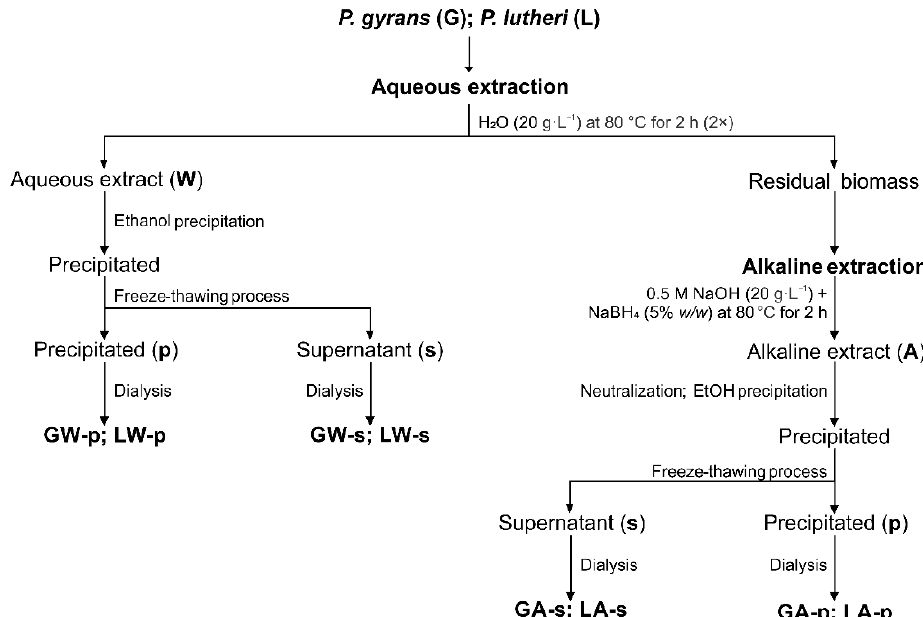
Figure 1. Extraction sequence and fractionation of crude extracts from microalgae P. gyrans and P. lutheri . G and L fractions correspond to P. gyrans and P. lutheri , respectively; W and A correspond to aqueous and alkaline extracts, respectively; and p and s correspond to precipitated and supernatant extracts, respectively.